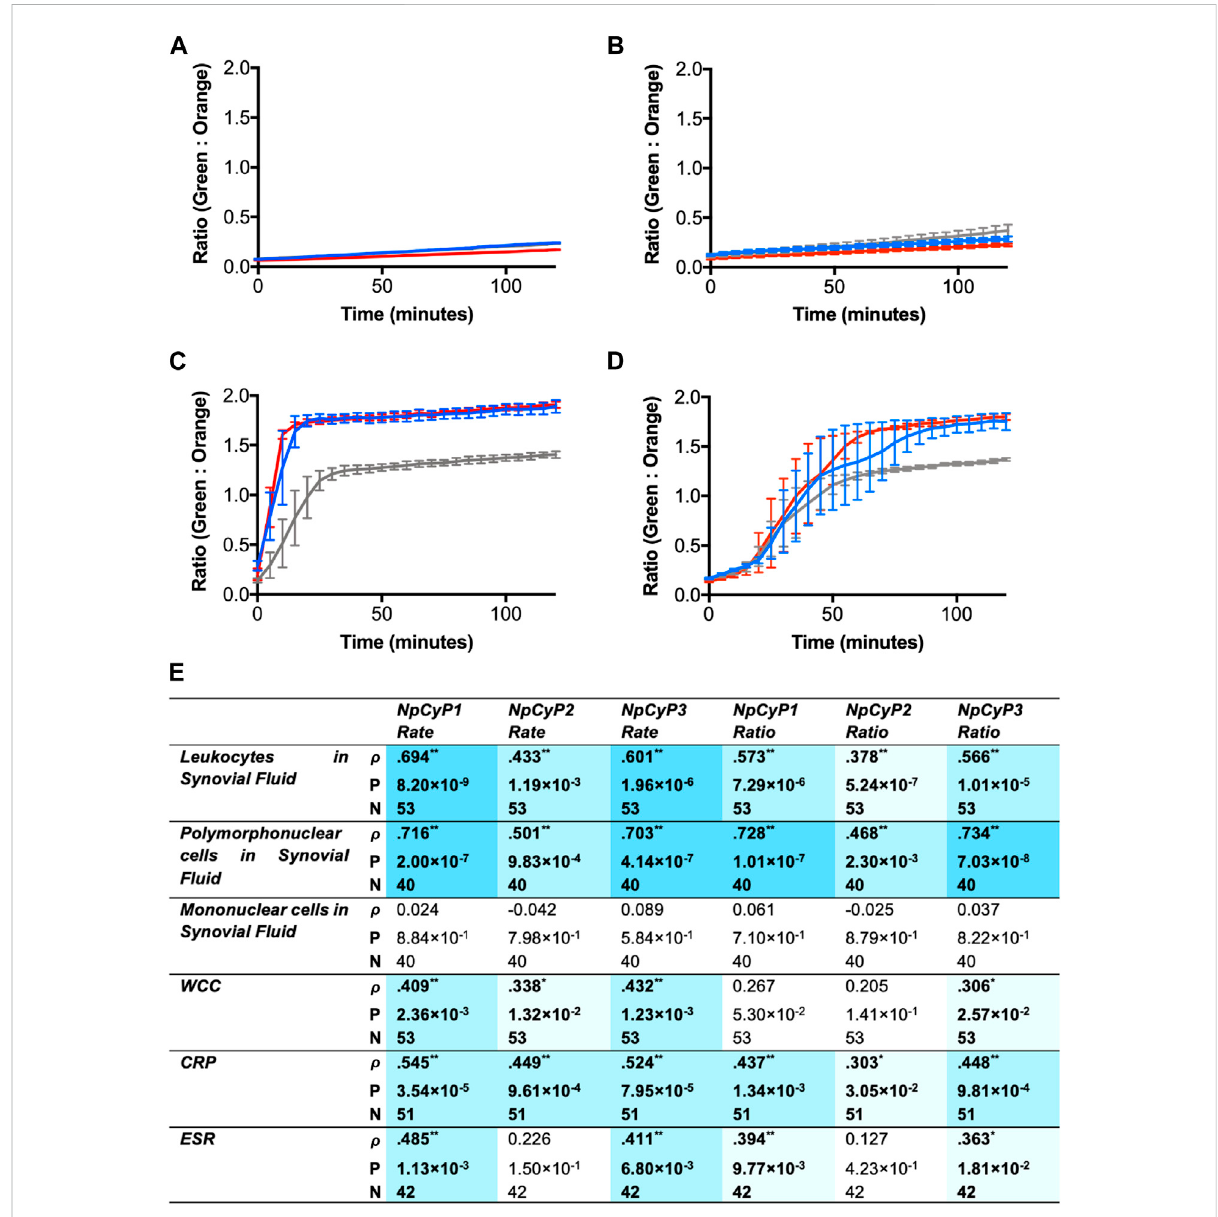
FIGURE 2 Fluorescence of MMP substrates (NpCyP1, NpCyP2, NpCyP3) over time in synovial fl uid- Graphs represent the fl uorescence ratio of NpCyP1 (blue), NpCyP2 (grey), and NpCyP3 (red) over time in synovial fl uid. Four representative graphs show varied fl uorescence response in four different synovial fl uid samples. Patients presented with a tibial fracture (A) , osteoarthritis (B) , rheumatoid arthritis (C) and gout (D) . Error bars show standard error of the mean from values obtained when the assay was repeated 3 times, and error bars are too small to be seen in panel (A) . Table shows Spearman ’ s correlation coef fi cient ( ρ ), two-tailed signi fi cance (P) and sample size (N) (E) . Variables with signi fi cant correlations ( p < 0.05) are representedinbold.Asterisksmarksigni fi cantcorrelations(* p < 0.05,** p < 0.01).Thecellsarecolourcodedsuchthattheintensityofthebluecolour correlates to weak (0.2 – 0.4), moderate (0.4 – 0.6), strong (0.6 – 0.8) or very strong (0.8 – 1)